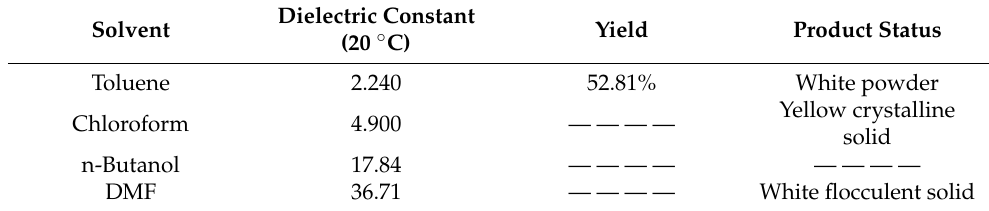
Table 1. The product yield with different solvents. Dielectric Constant Solvent Yield Product Status (20 ◦ C) Toluene 2.240 52.81% White powder Yellow crystalline Chloroform 4.900 — — — — solid n-Butanol 17.84 — — — — — — — — DMF 36.71 — — — — White flocculent solid